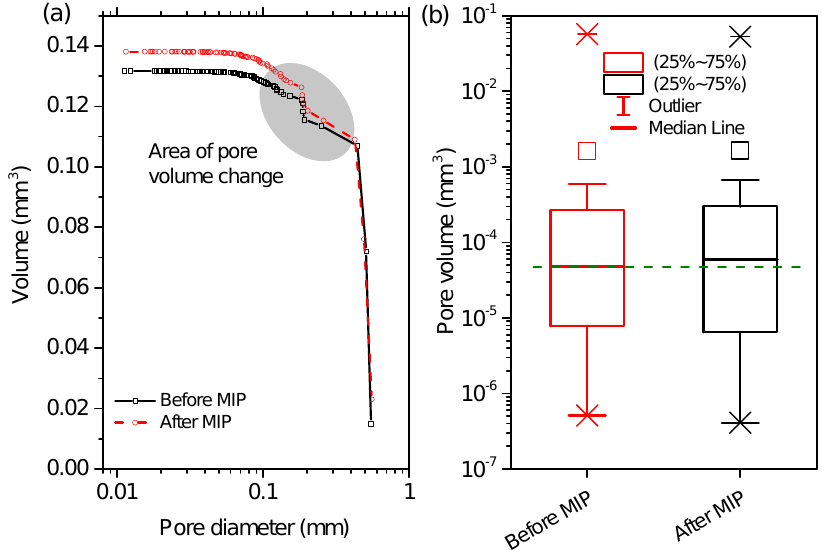
Figure 12. ( a ) comparative plots of pore size distribution of a VOI in the mortar sample before and after mercury intrusion, and ( b ) the statistic results of the pore